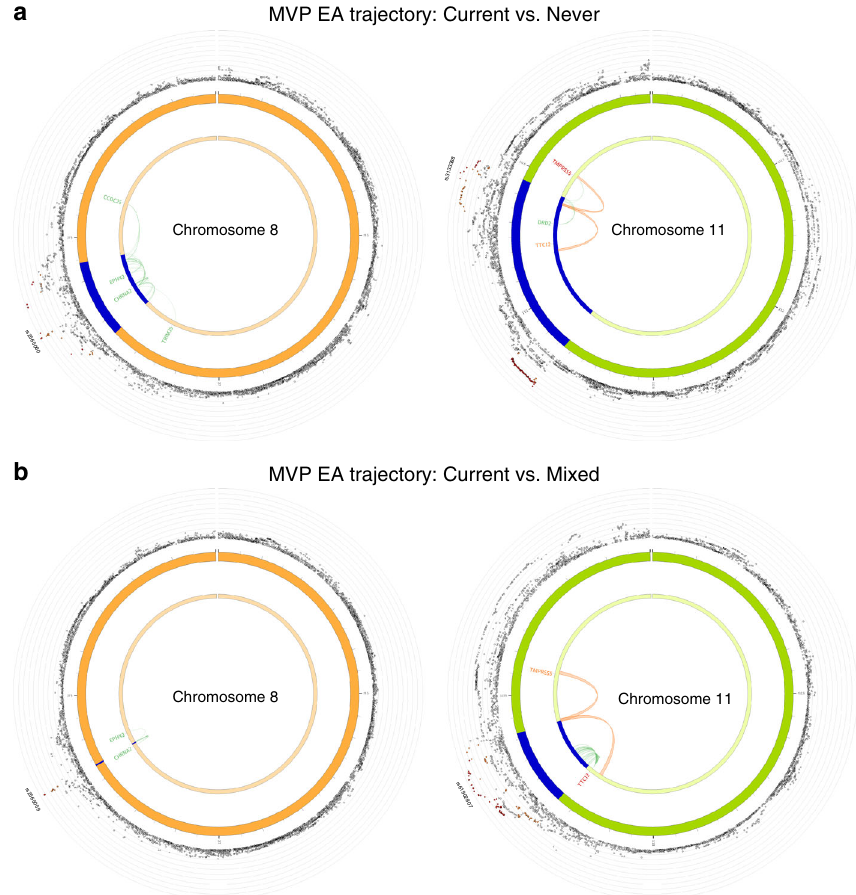
Fig. 3 Gene prioritization for smoking trajectory contrasts. Functional mapping and annotation (FUMA) gene prioritization for smoking trajectory contrast I (current vs. never ( a )) and contrast II (current vs. mixed ( b )) in European American samples in the Million Veteran Program. The outer layer shows chromosomal Manhattan plots. Region in blue shows genome-wide signi fi cant locus. Genes mapped by chromatin interactions and eQTLs are colored in orange and green, respectively. Genes mapped by both chromatin interactions and eQTLs are colored in